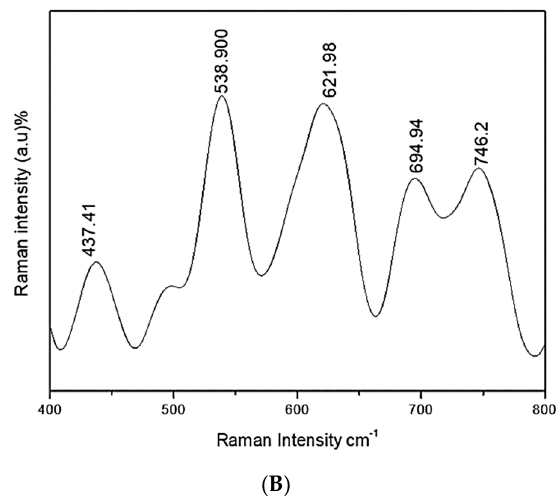
Figure 1. ( A ) XRD pattern and ( B ) RAMAN spectra (excited at 514 nm) of In 0.1 Ga 0.9 N thin film.